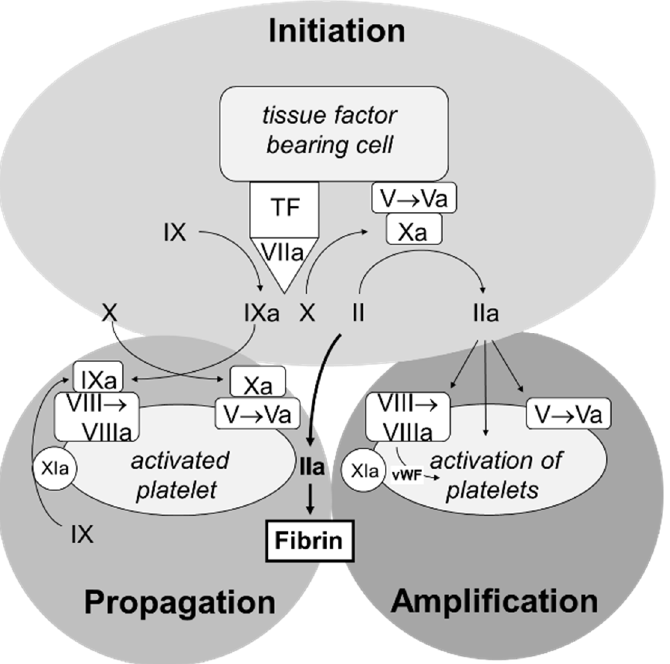
Figure 2. Cell-based coagulation model showing the contribution of tissue factor bearing cells and platelets in hemostasis.